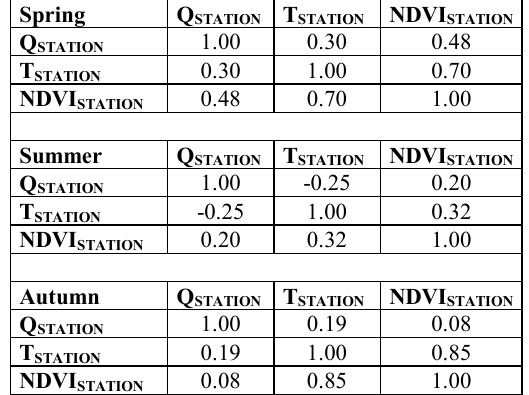
Table 5. The correlation coefficients between the precipitation (Q), air temperature (T) and NDVI obtained for the growing seasons on the base of ground observations